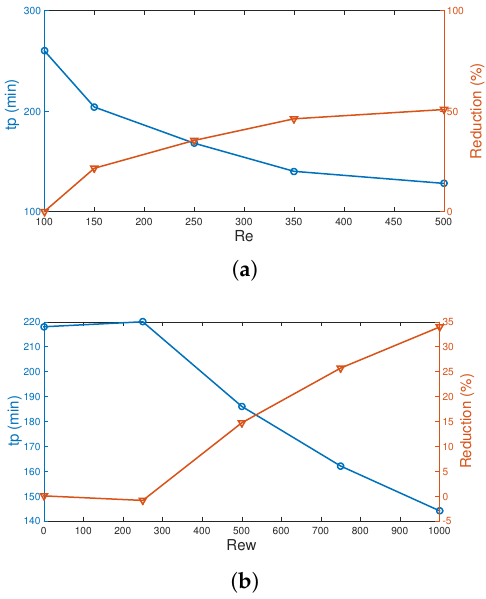
Figure 8. Complete phase transition time (tp in minutes) with varying Re ( a ) and rotational Re ( b ). The amount of reduction in the tp is also presented in the figures ( di = 0.25 L 1, L 0 = 0.6 L 1, yp = 0.1 H, and NC =